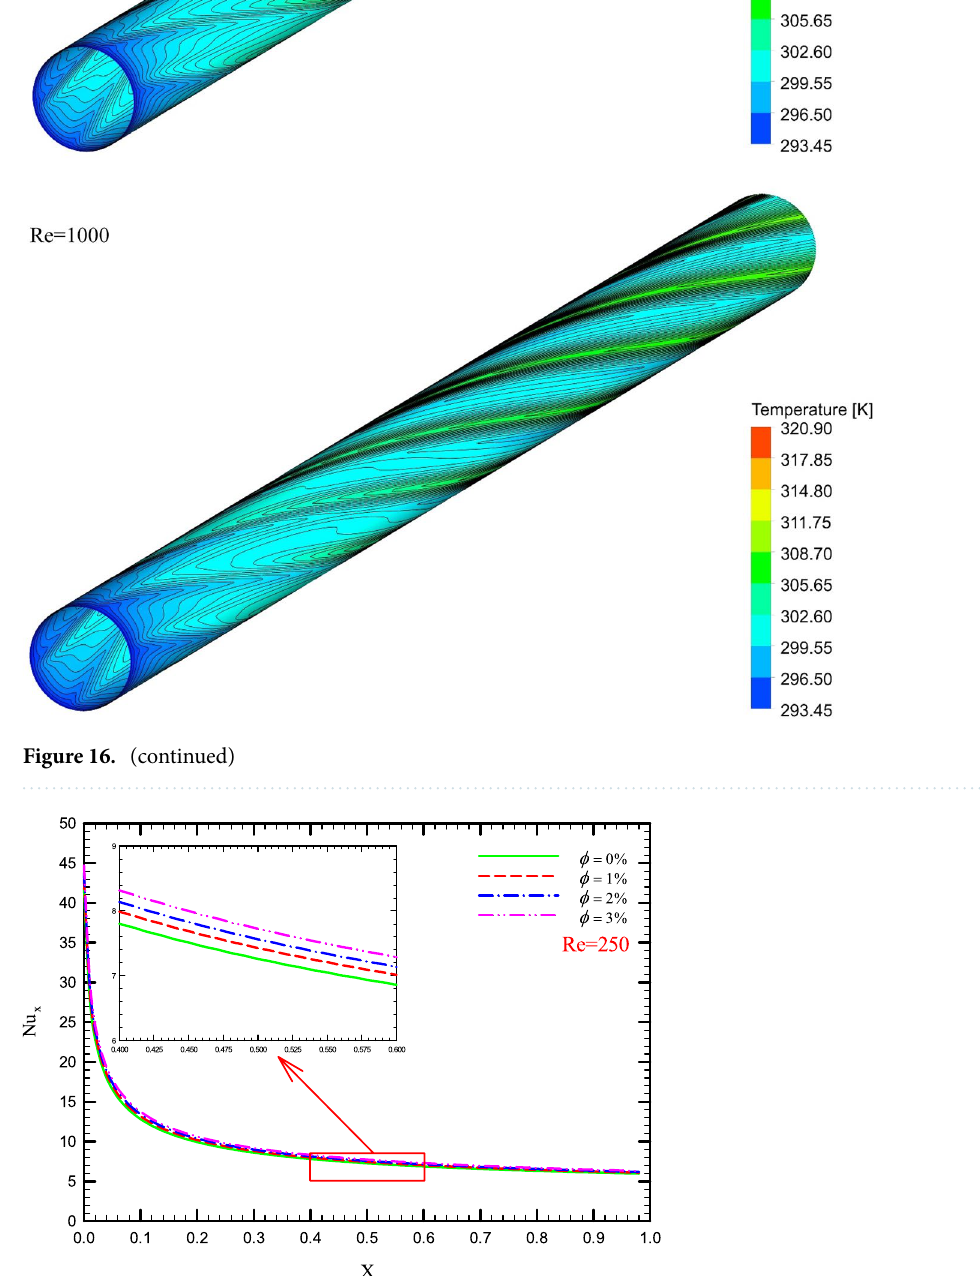
Figure 17. Nu x versus dimensionless length in Re = 250 for Case